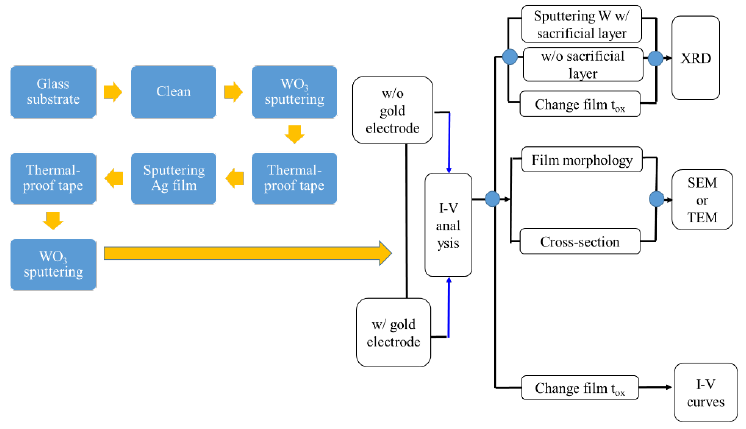
Figure 4. Schematic chart of process flow to fabricate a WAW film without (w/o) or with (w/) gold electrodes.